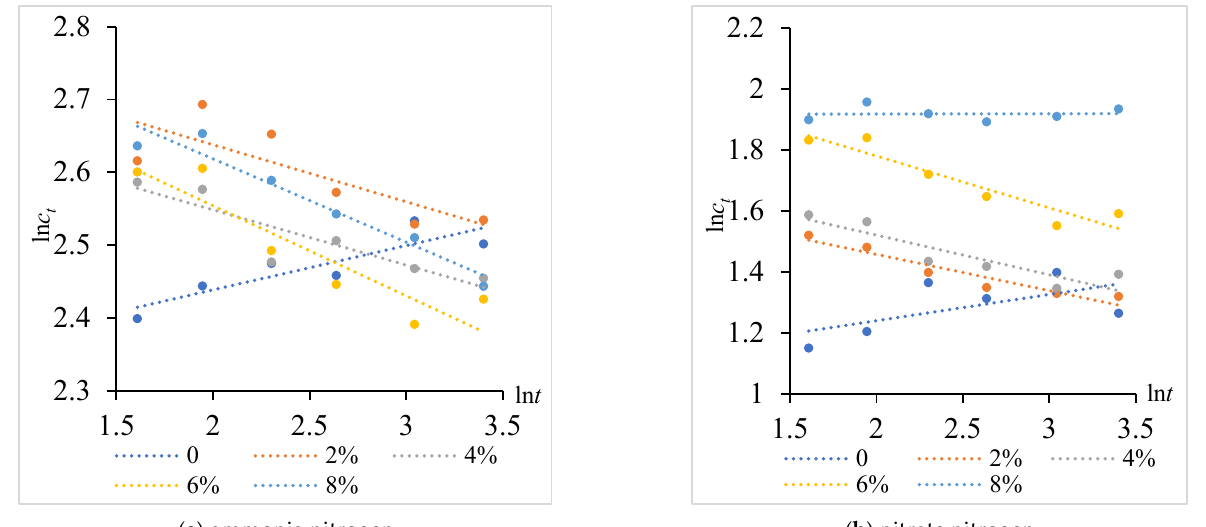
Figure 6. Double logarithm regression relationship between ammonia nitrogen/nitrate nitrogen concentration in overlying water and test days.